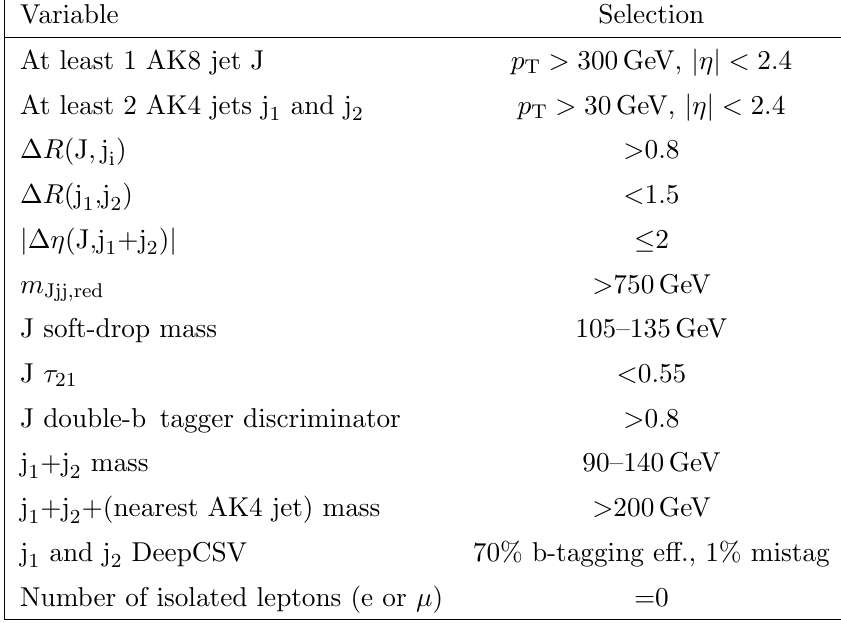
Table 2 . Summary of the o(cid:15)ine selection criteria for semi-resolved HH ! bbbb